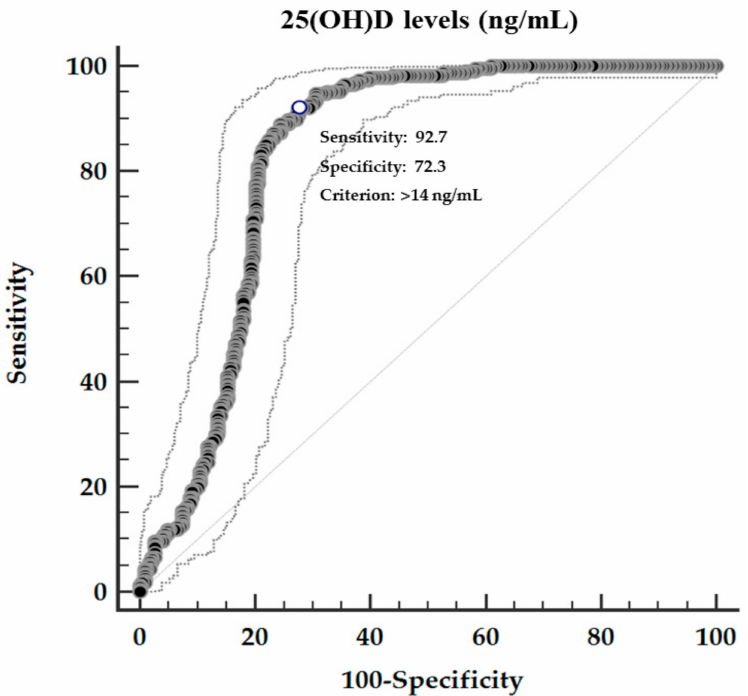
Figure 5. ROC for predictive values of 25(OH)D levels in detecting